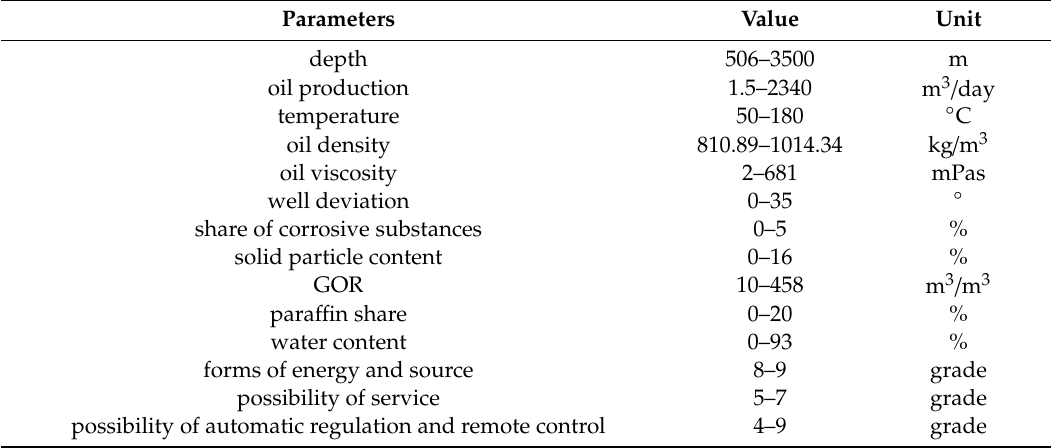
Table 3. Input data range for forming the model